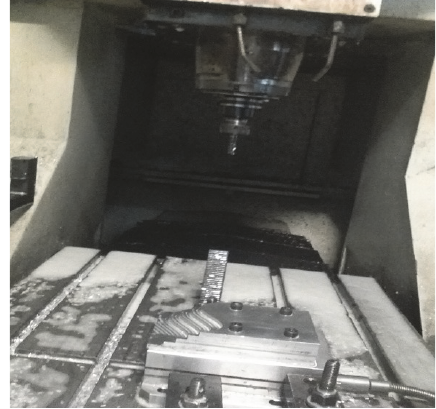
Figure 10: Milling